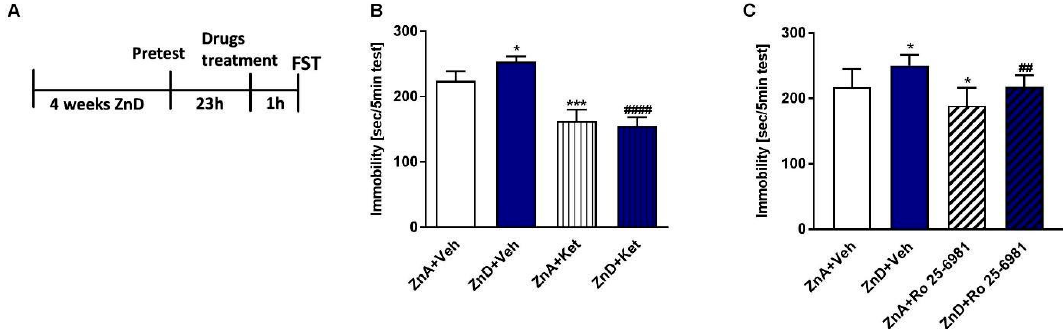
Figure 1. The effect of a single dose of ketamine (Ket) and Ro 25 ‐ 6981 in the forced swim test (FST) in rats subjected to zinc deficiency. ( A ) Experimental schedule of drug treatments and behavioral test.